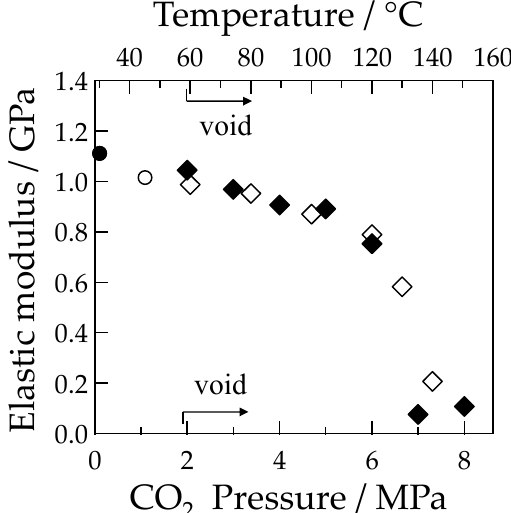
Figure 4. Elastic modulus of the OD-PC as a function of temperature and CO 2 pressure; ○ ♢ , temperature; ● ♦ , CO 2 pressure; ○ ● , without void; ♢ ♦, void .